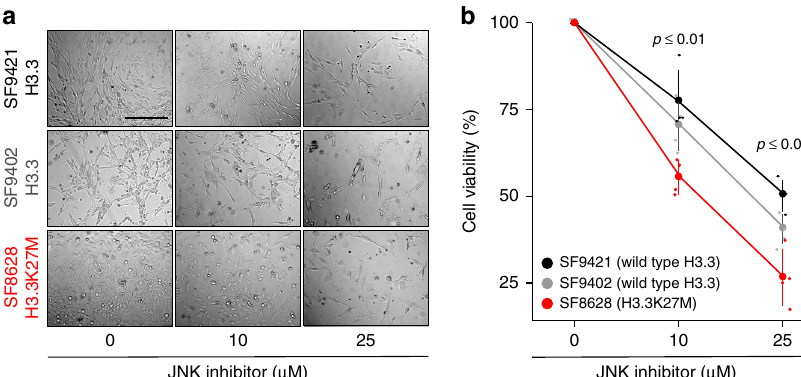
Fig. 6 JNK inhibition decreases proliferation of human glioma-derived H3.3K27M cells. a , b Transmitted light pictures ( a ) and cell viability plots ( b ) of human glioma-derived cells with wild type (SF9421, black; SF9402, gray) or K27M mutant (SF8628, red) H3.3, treated with different concentrations of JNK inhibitor SP600125. N = 4 for all conditions. Signi fi cance was tested for using one-way ANOVA